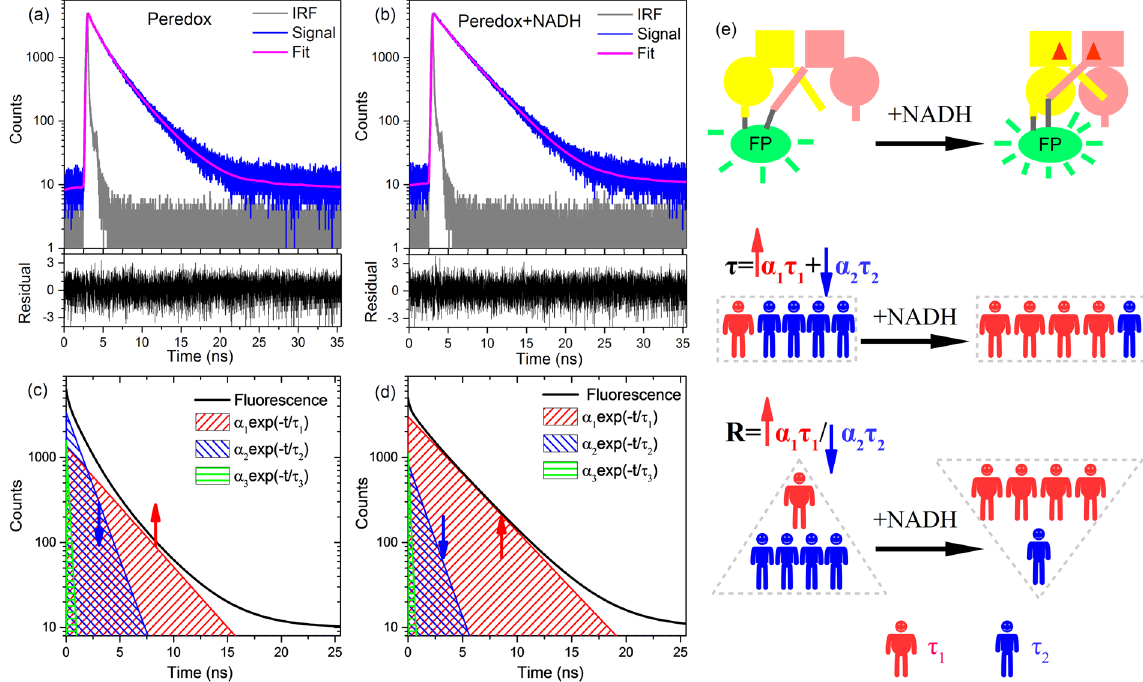
Figure 1. Time-resolved fluorescence decay curves of Peredox (0.1 μ M) in the absence of NADH ( a ) and in the presence of 0.1 μ M NADH ( b ). The decay curves (signal) were fitted by convoluting the IRF with a tri-exponential decay function as equation (1). The fractional amplitudes ( α 1 , α 2 , α 3 ), lifetimes ( τ 1 , τ 2 , τ 3 ) and goodness of fit ( χ 2 ) are 26.8%, 41.8%, 31.4%, 3.1 ns, 1.3 ns, 0.18 ns, 1.11 for panel (a) and 60.4%, 17.1%, 22.5%, 3.2 ns, 1.2 ns, 0.16 ns, 1.09 for panel (b), respectively. The fluorescence was excited at 405 nm and detected at 515 nm. Figure ( c ) and ( d ) showed time-resolved fluorescence decay curves described by a tri-exponential decay function . The parameters used in panel (c) were obtained from Figure ( a ), and panel (d) from Figure ( b ). Thus, the panels (c) and (d) correspond to the fluorescence decay curves of Peredox in the absence and in the presence of NADH, respectively. ( e ) Schematic illustration of the variation of fluorescence lifetime (amplitude-weighted, τ ) and ratio of fractional intensities ( R ) after NADH bind to